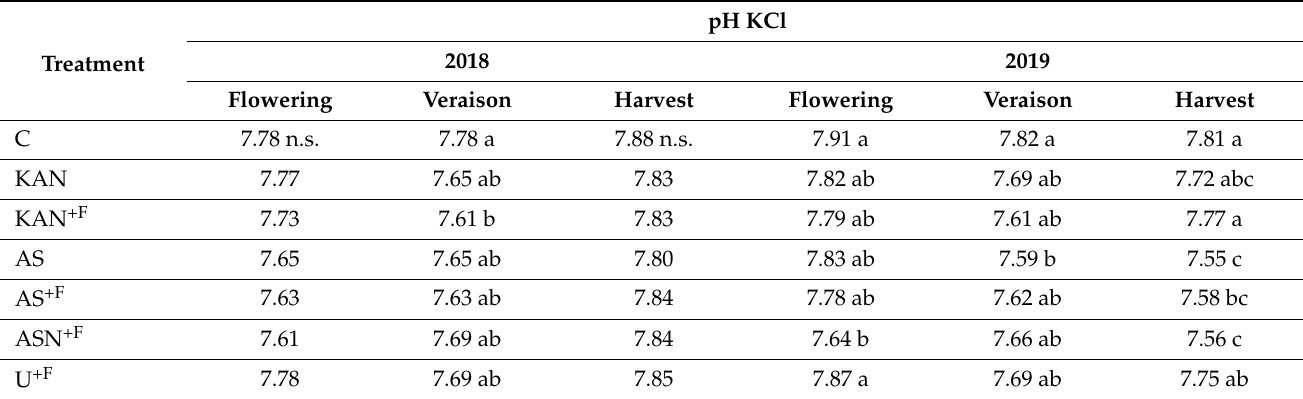
Table 6. Influence of nitrogen fertilization on the exchangeable soil acidity (pH